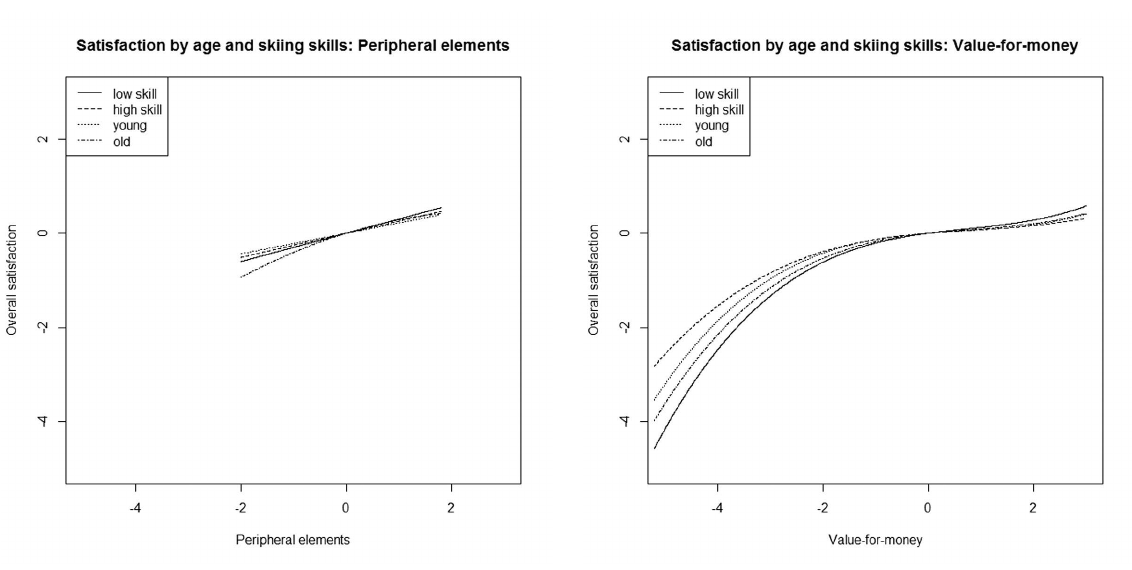
Figure 6. Ski Peripherals in two age and skiing skill groups